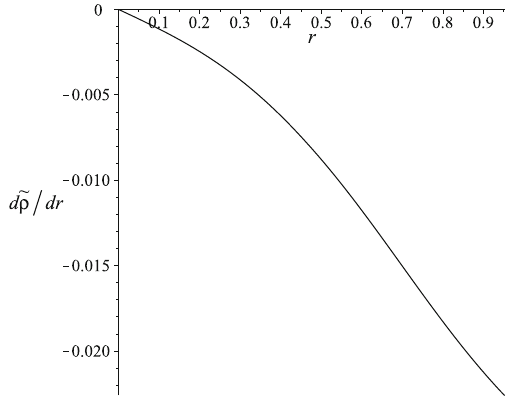
Fig. 22 Gradient of the energy density for the solution obtained with the second algorithm with ˜ F (cid:9)= 0 form the isotropic Gold III solution